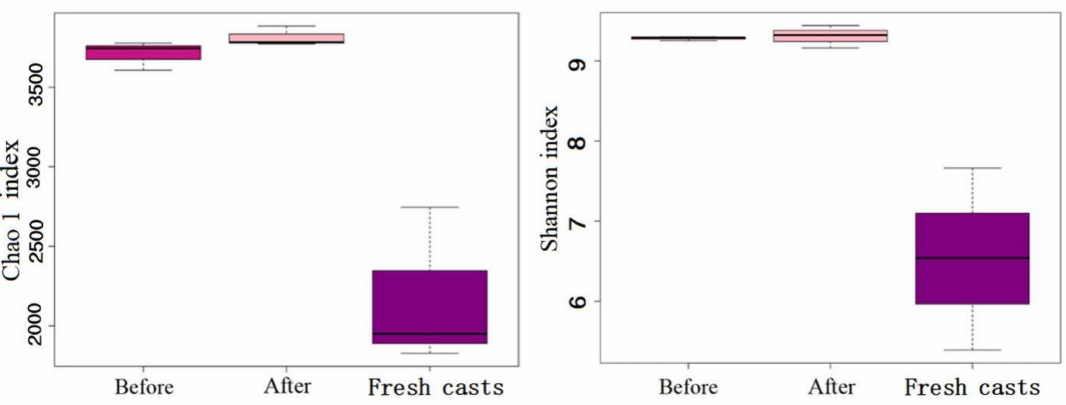
Figure 8. Alpha diversity of microbial communities in fresh casts and before and after vermicompost- ing. Chao1 index reflects the richness of bacteria, and Shannon index reflects microbial